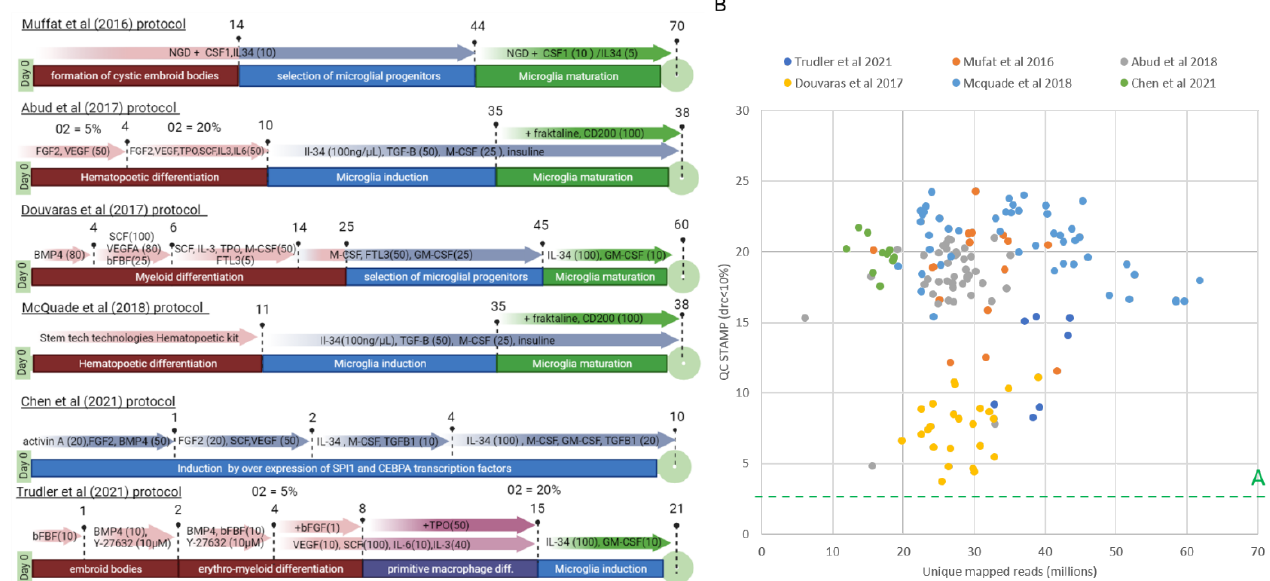
Figure 1. Overview of the iMGL protocols and the quality of their RNA-Seq libraries. ( A ) Short summary of the human iMGL differentiation protocols compared in this study. Protocols are organized by chronological order of publication in the literature. The different steps of the cell differentiation were highlighted and associated with the corresponding treatment (when not specified the unit’s concentration is ng/ µ L). Each time point corresponds either to a key step in the cellular differentiation or a change in medium composition. The O 2 % in the medium was also added when modified during the protocol. When not specified, the O 2 concentration is considered to be normoxya (O 2 = 20%). ( B ) Scatter plot of the quality of each RNA-Seq libraries associated with the compared protocols as assessed by the NGS-QC Generator tool compared to their corresponding unique mapped sequenced reads. The green dashed line demarcates the quality “A” threshold assessed by the NGS-QC Generator database, issued from the analysis of more than 90 thousand public datasets (http://ngs-qc.org/accessed on 1 October 2021).